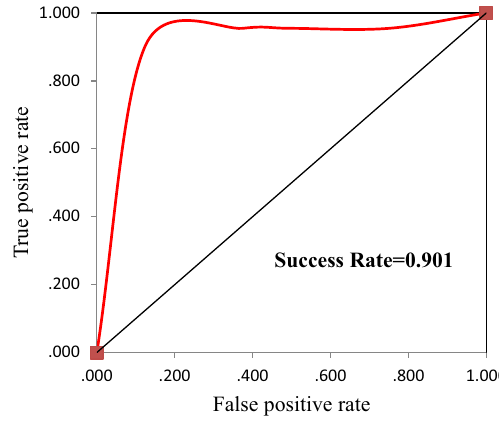
Fig. 6 ROC curve of success rate of the FR